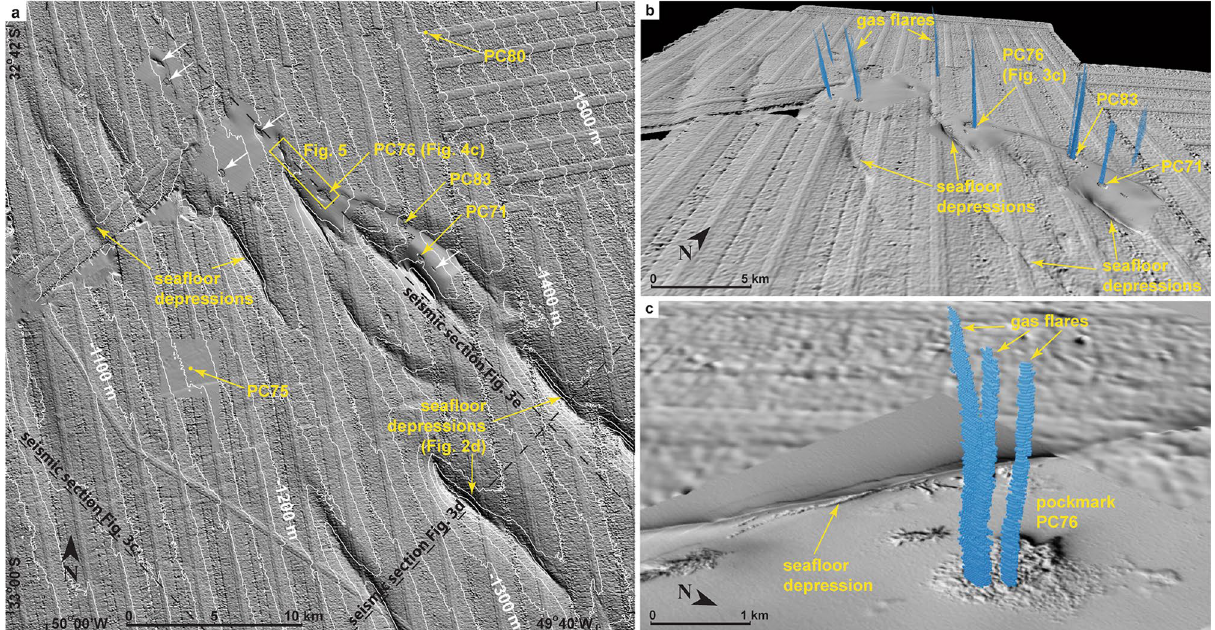
Figure 4. ( a ) Bathymetric map (shaded relief with isolines every 20 m) of part of the study area (see Fig. 1) obtained from a previous study 38 showing aligned and elongate seafloor depressions, the trace of the used seismic profiles used in this study, and the locations of 5 piston cores obtained both in pockmarks (PC71, PC76 and PC83) and in background areas (PC75 and PC80). These depressions are the seafloor expression of crestal faults (see Fig. 2f). White arrows point to additional pockmarks in the area. A conductivity, temperature, depth profile of the water column was obtained in the same location of PC83. ( b ) 3D view of the study area showing sonar-detected water column gas flares (in blue) in relation to the seafloor depressions and pockmarks. Note the alignment of the gas flares along the NE–SW trend of main seafloor depressions. Flares in pockmarks near PC71, PC76, and PC83 were inspected with a remotely operated vehicle. Gas hydrate was recovered in all piston cores within pockmarks. ( c ) Detail of ( b ) showing multiple gas flares in pockmark PC76 and an adjacent seafloor depression. The bathymetry data was processed in Surfer (version 15; https:// www. golde nsoft ware. com/ produ cts/ surfer) and the assembly of bathymetry and gas flares was completed using QPS Fledermaus (version 7; https:// www. qps. nl/ flede rmaus/).